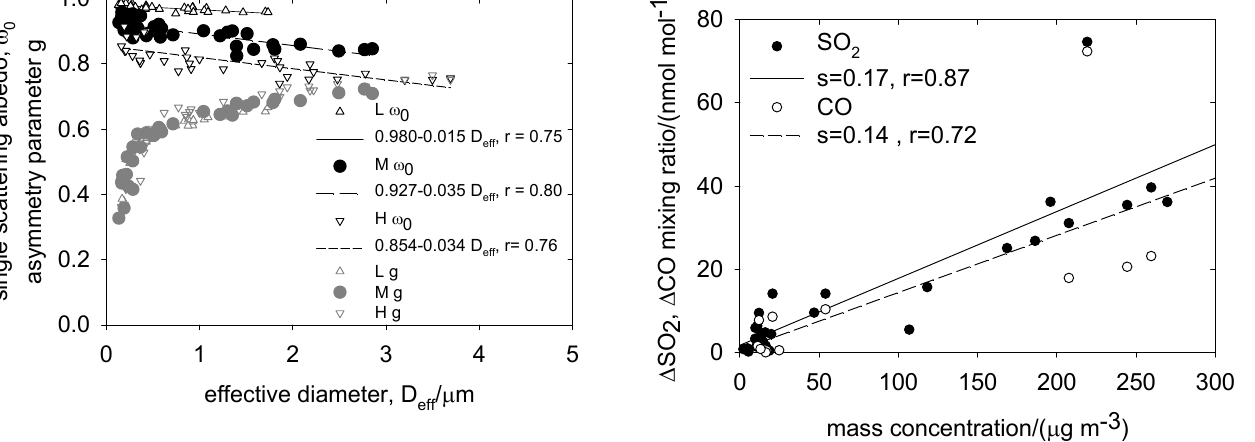
Fig. 26. Correlation between SO 2 and CO mixing ratio increases over background with particle mass concentration (analysis for case M). The points in the upper part of the diagram with largest gas mixing ratios result from the measurements on 2 May. The legend identifies the correlation coefficients r of the linear